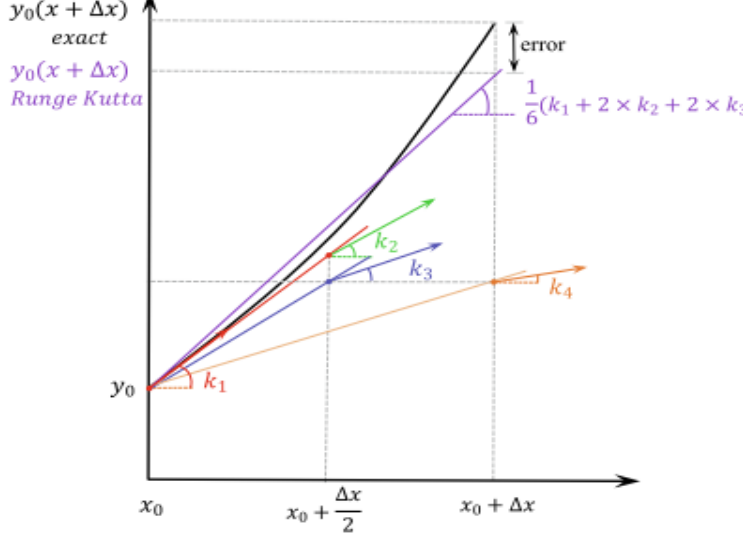
Figure 5. Slopes used in RK method.